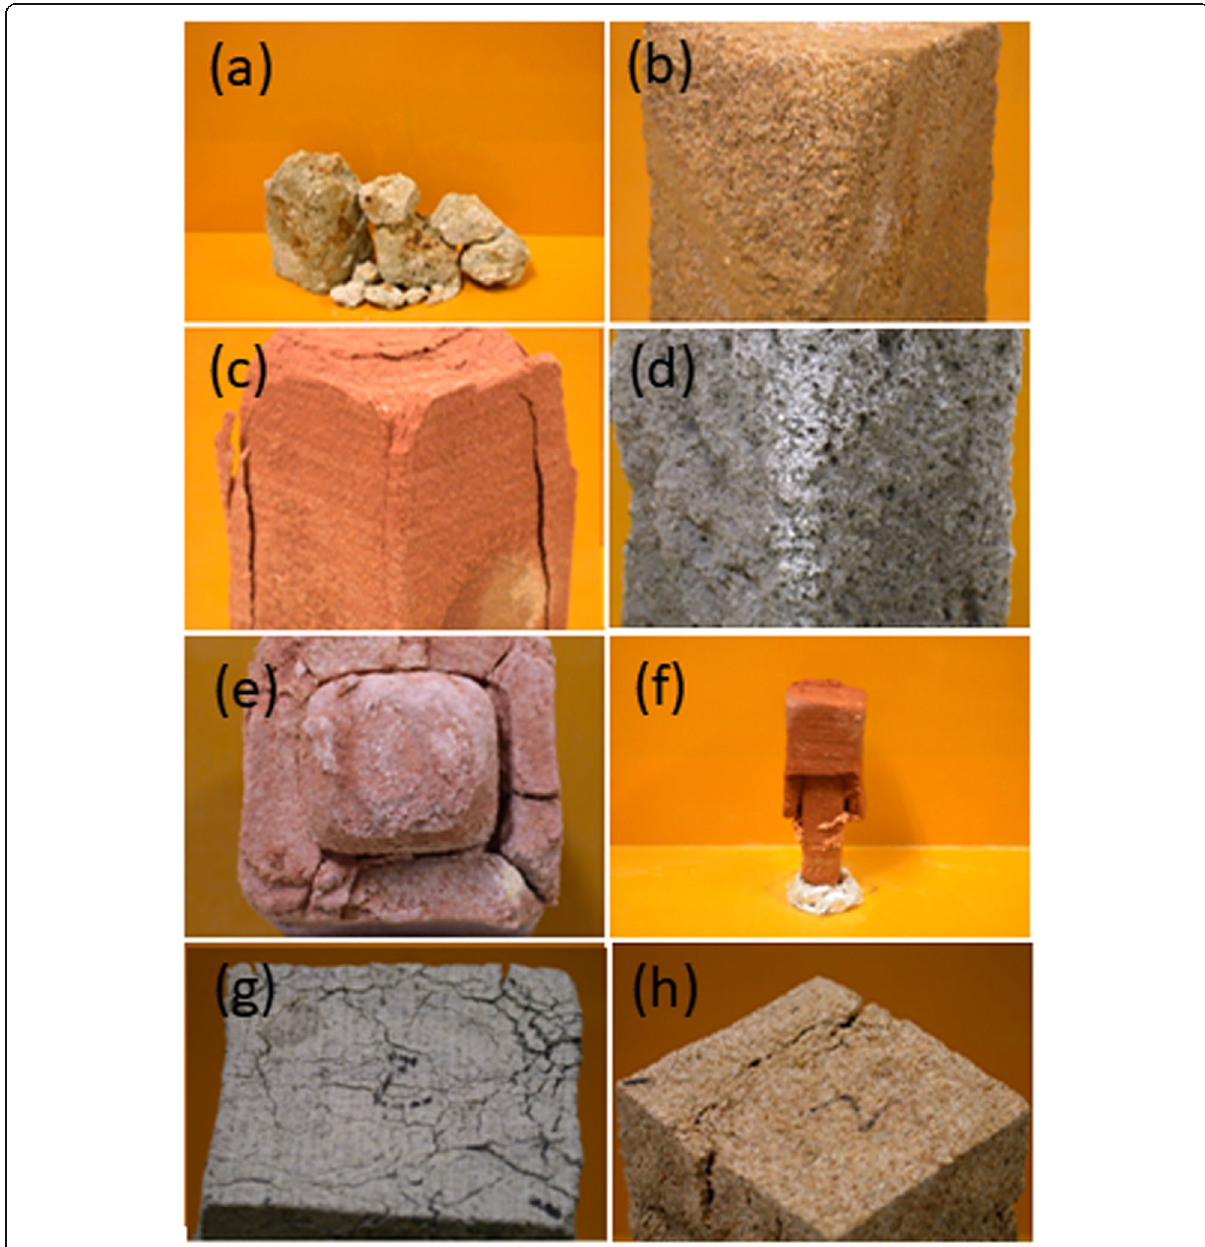
Fig. 1 Patterns of disintegration due to weathering. a Cracking and disintegration, b crumbling, c scaling, d surface pitting, e thick scaling, f delamination, g cracking, and h expansive dilatation patterns. Scale bar shows 10